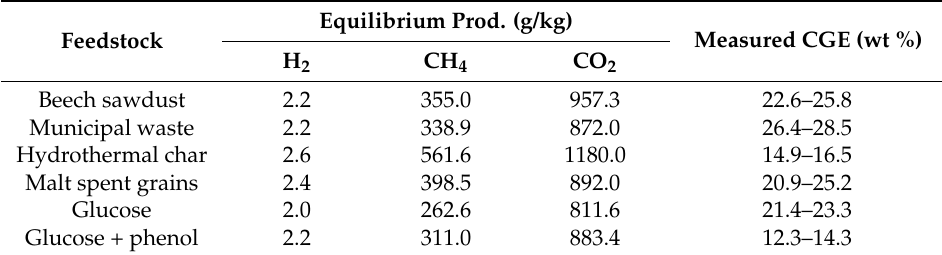
Table 3. Equilibrium products for the SCWG of the considered feedstock at 15%, 400 °C, and 30 MPa. Values are in g GAS /kg FEEDSTOCK .